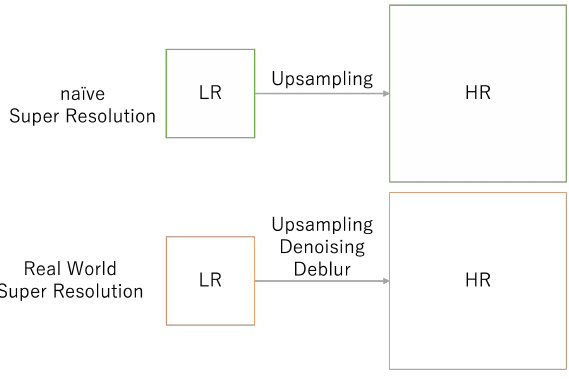
Figure 1. Overview of Real-World Super Resolution. range of applications of SISR technology for satellite imagery, such as further increasing the resolution of sub-meter imagery like WorldView-2/3, and increasing the resolution of free im- agery such as Landsat and Sentinel. The same problem of de- gradation function occurs when applying the SISR technique to such optical satellite images. Consider the case where an optical satellite image is upsampled to a resolution equivalent to that of an aerial photo, for example. Since optical